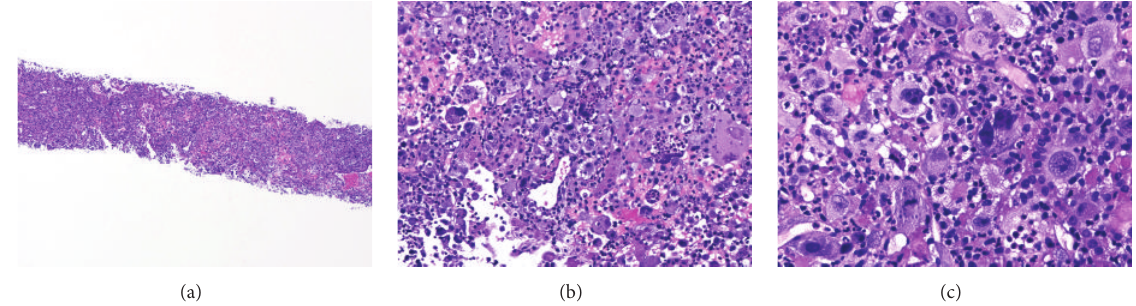
Figure 2: (a) Hypercellular cores comprised of sheets of noncohesive large tumor cells and neutrophils infiltrating renal tubules (H&E, 40x). (b) Tumor cells engorged with neutrophils and intimately juxtaposed with renal tubular epithelium (H&E, 400x). (c) Pleomorphic tumor cells with abundant eosinophilic to vacuolated cytoplasm, coarse nuclear chromatin, and multiple prominent eosinophilic nucleoli (H&E, 600x).